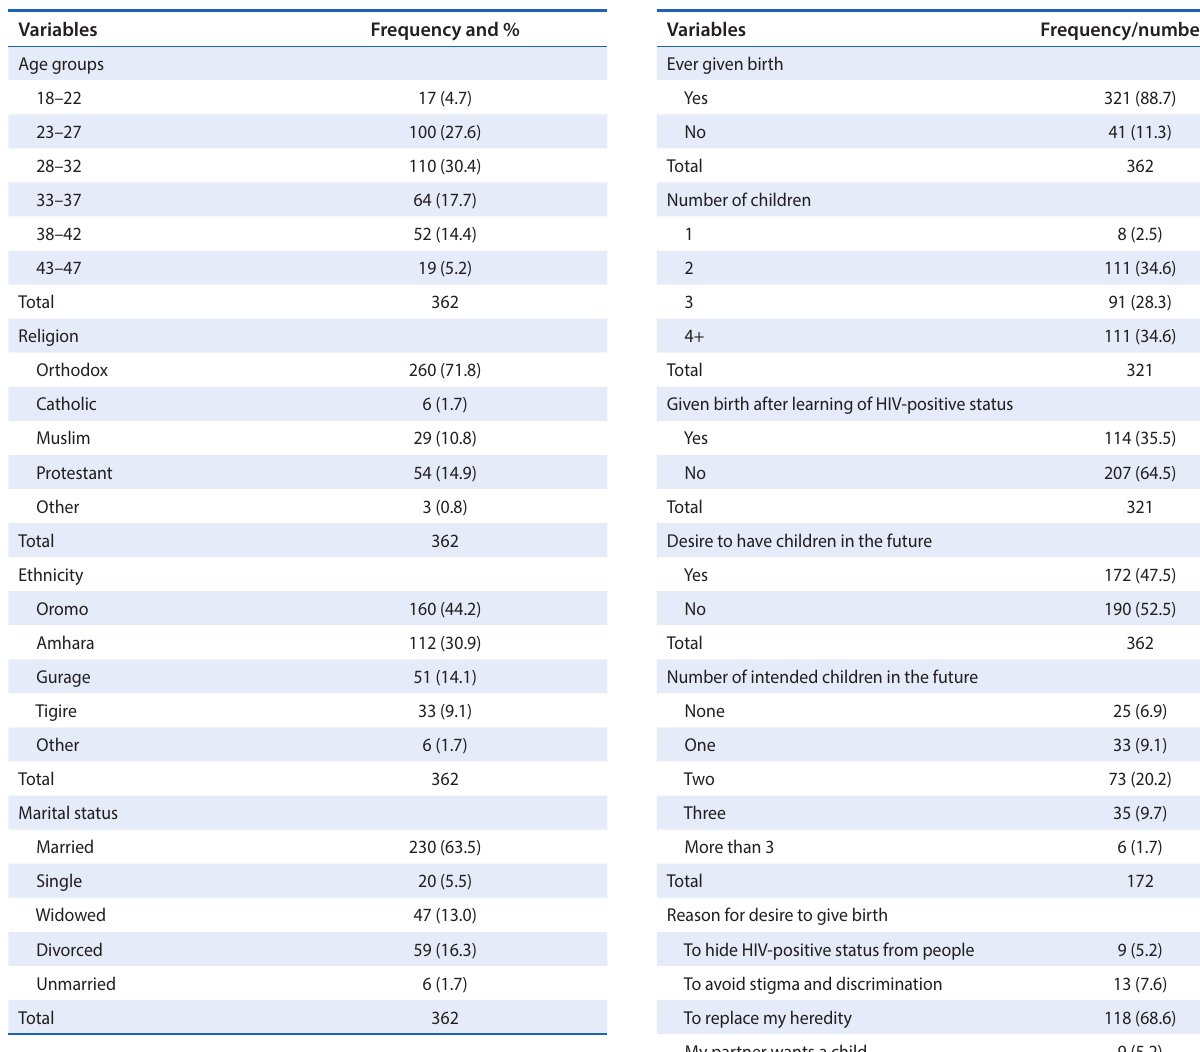
Table 1: Demographics of the participants Table 2: Frequency distributions of fertility intentions